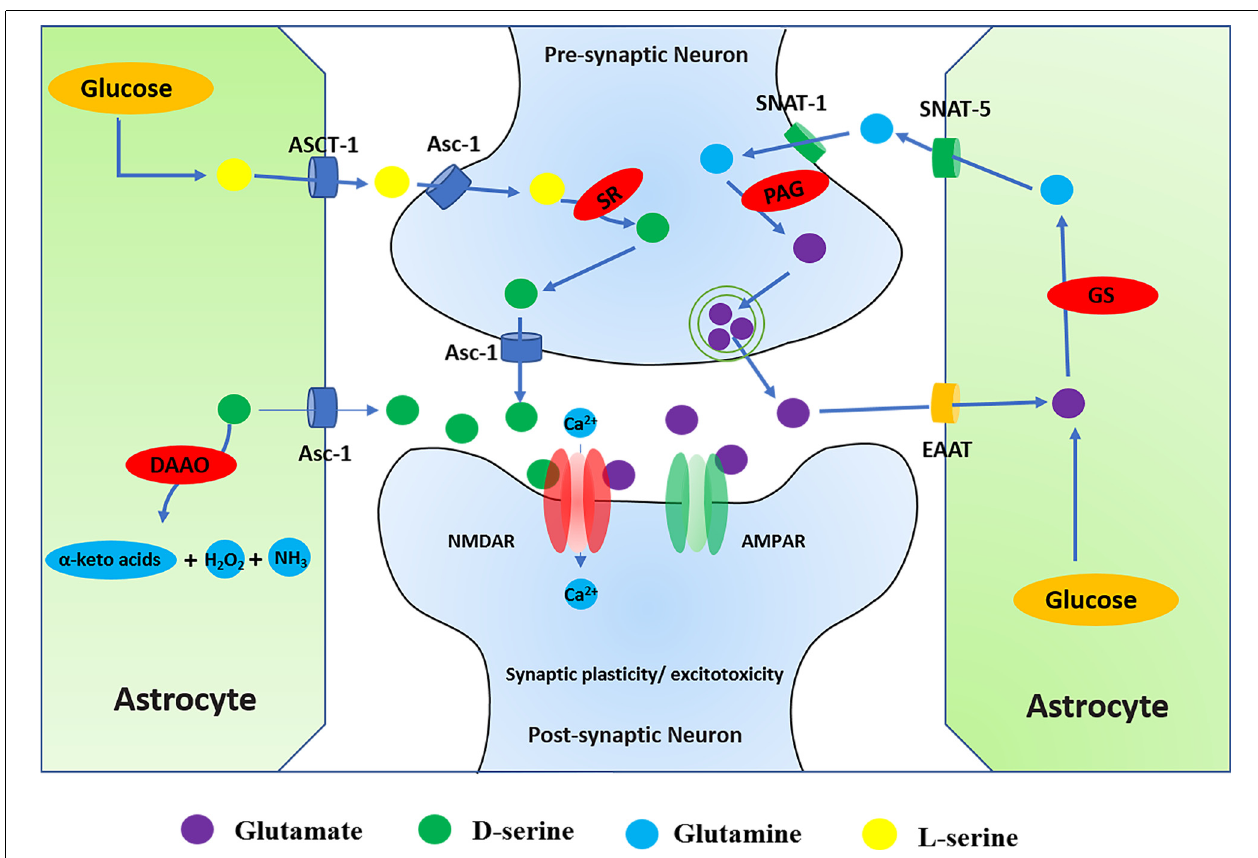
FIGURE 4 | Regulation of NMDARs by D-serine and glutamate. (1) Glutamate can directly act on NMDAR, and the glutamate-glutamine cycle is involved in the regulation of NMDAR. Glutamate-glutamine cycle: glutamate can be directly synthesized de novo by astrocytes or indirectly produced from glucose molecules through the actions of pyruvate dehydrogenase and astrocyte-specific enzyme pyruvate carboxylase in the brain. Meanwhile, extracellular glutamate can be transferred to astrocytes by ETTA2 (GLT-1) and then converted to glutamine by glutamine synthetase (GS). Glutamine is transported by SNAT-5 to the extracellular environment, where it can then be transferred to neurons by SNAT-1. In the neuron, glutamine is degraded by PAG into glutamate and ammonia. Glutamate enters the synaptic vesicles in the pre-synaptic neurons and then is released from the pre-synaptic membrane into the synaptic cleave. It directly acts on the NMDAR in